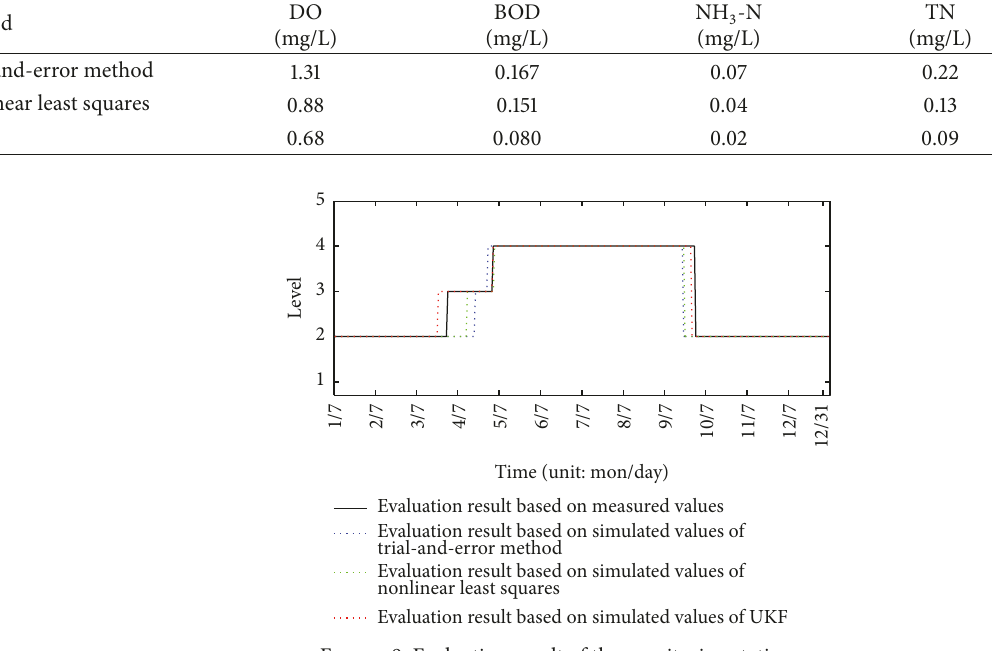
Figure 9: Evaluation result of the monitoring station.